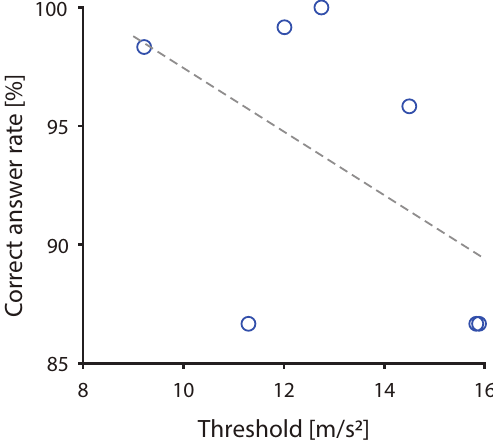
Figure 9. Correlation between threshold and correct answer